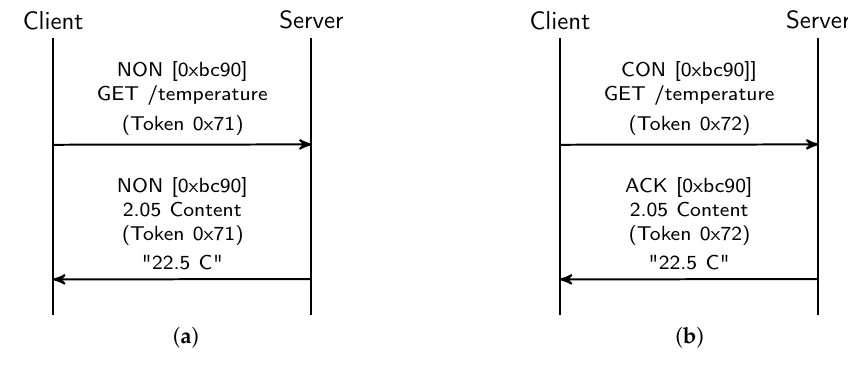
Figure 1. CoAP messages. ( a ) Non-confirmable CoAP GET request; ( b ) Request with piggybacked